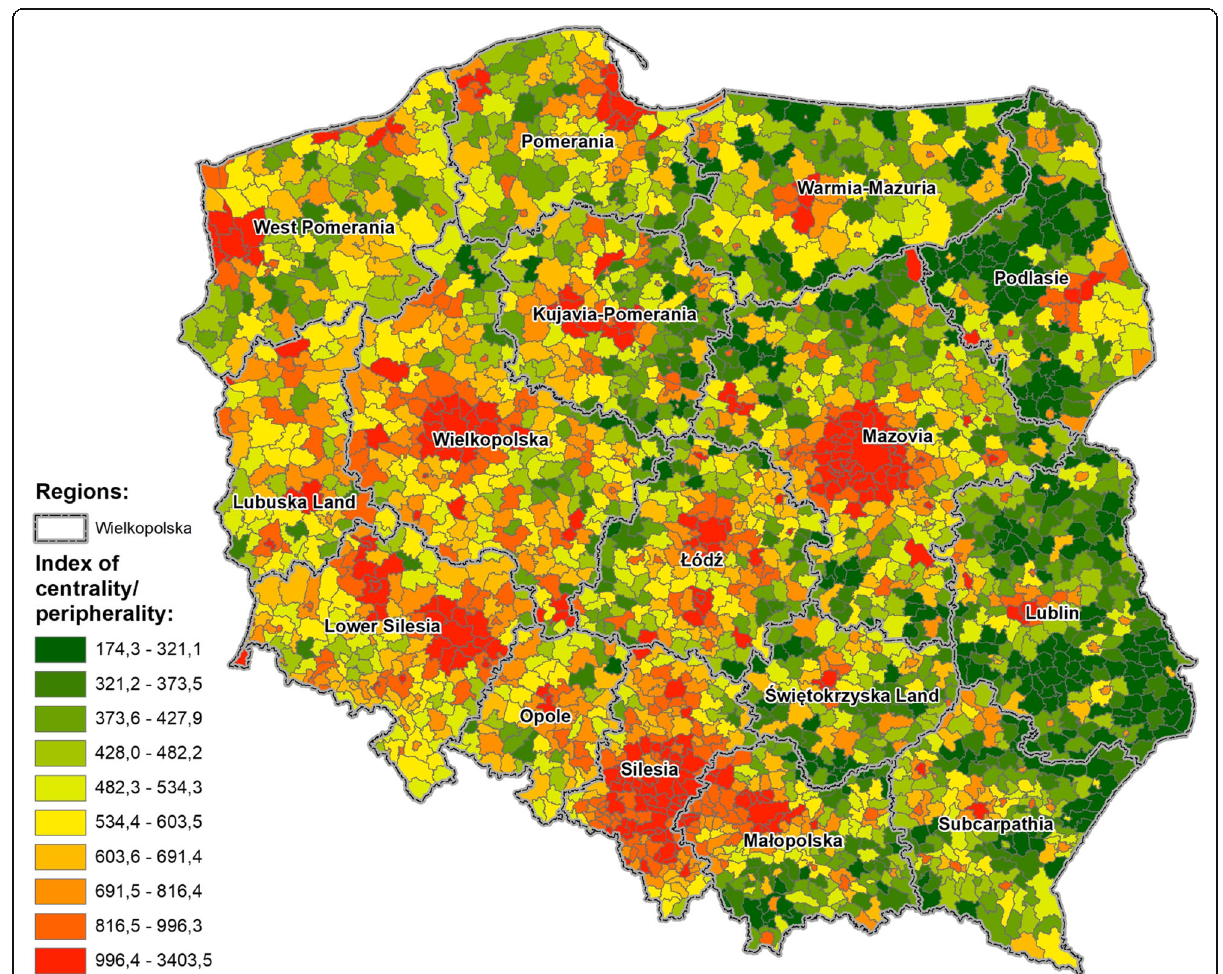
Fig. 1 Spatial centre-periphery structure in Poland. Source: own elaboration based on the Ministry of Finance